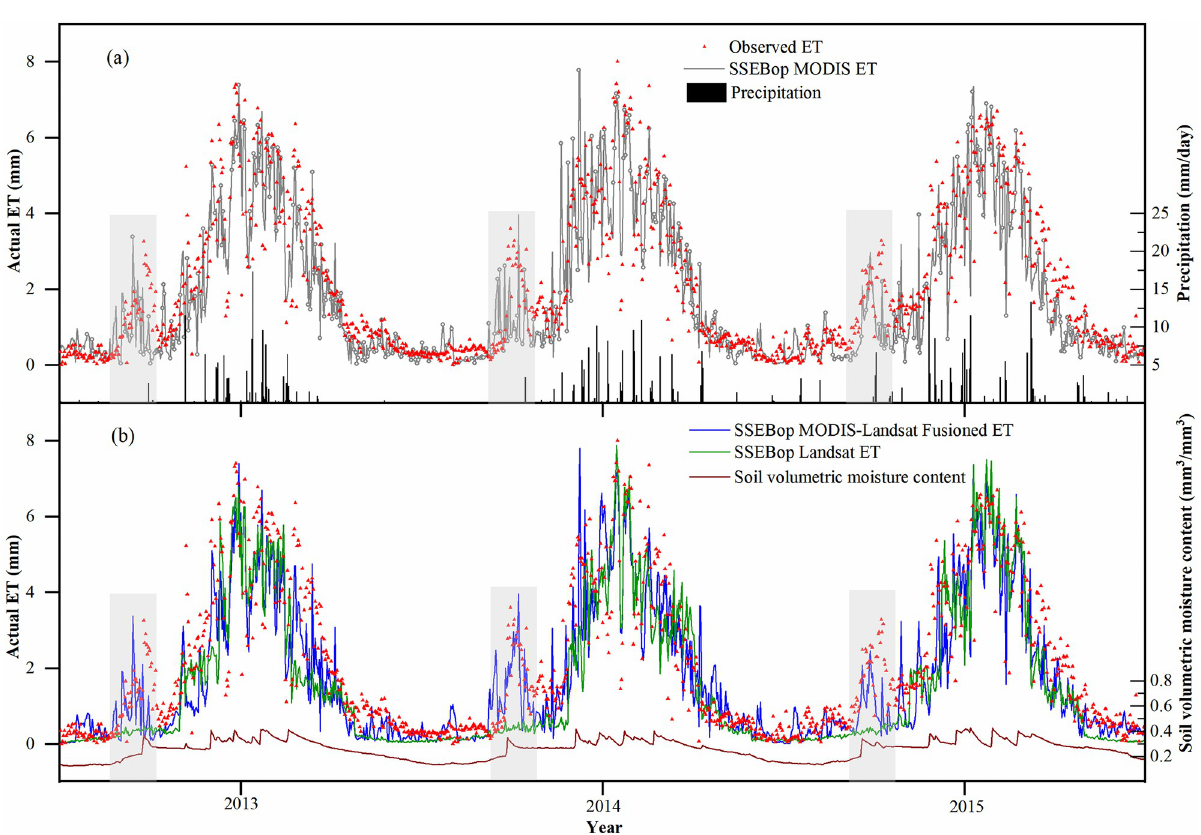
Fig 5. Comparisons of the SSEBop MODIS ET, SSEBop MODIS-Landsat Fusioned ET, SSEBop Landsat ET with the observed ET, soil moisture, and the precipitation.